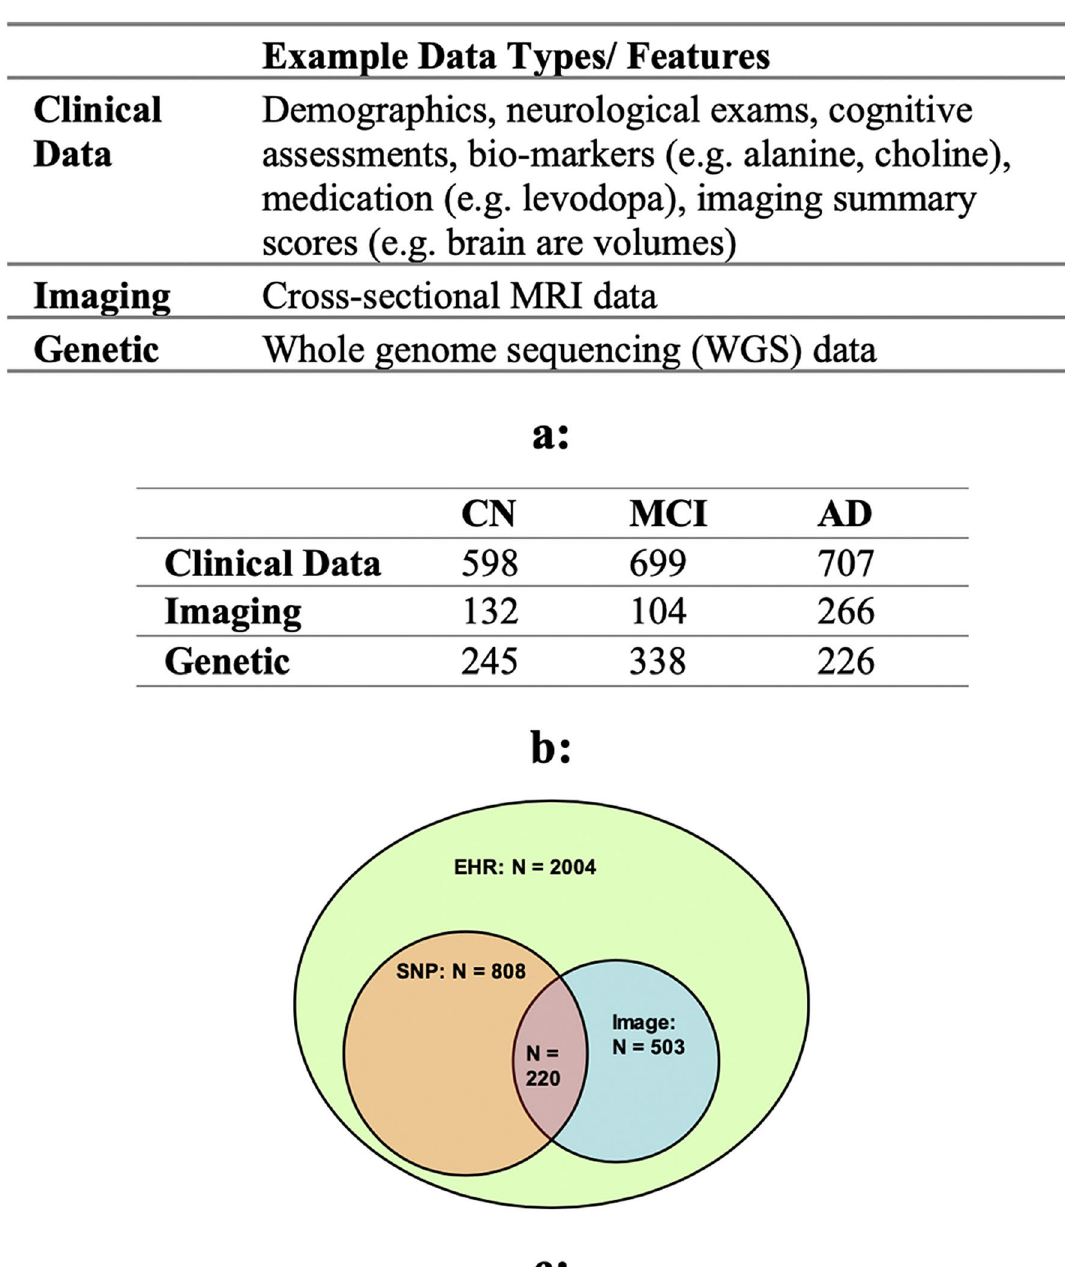
stage. ( CN controls, MCI mild cognitive disorder, and AD Alzheimer’s disease). 220 patients have all the three data modalities, 588 patients have SNP and EHR, 283 patients have imaging and EHR, the remaining patients have only EHR